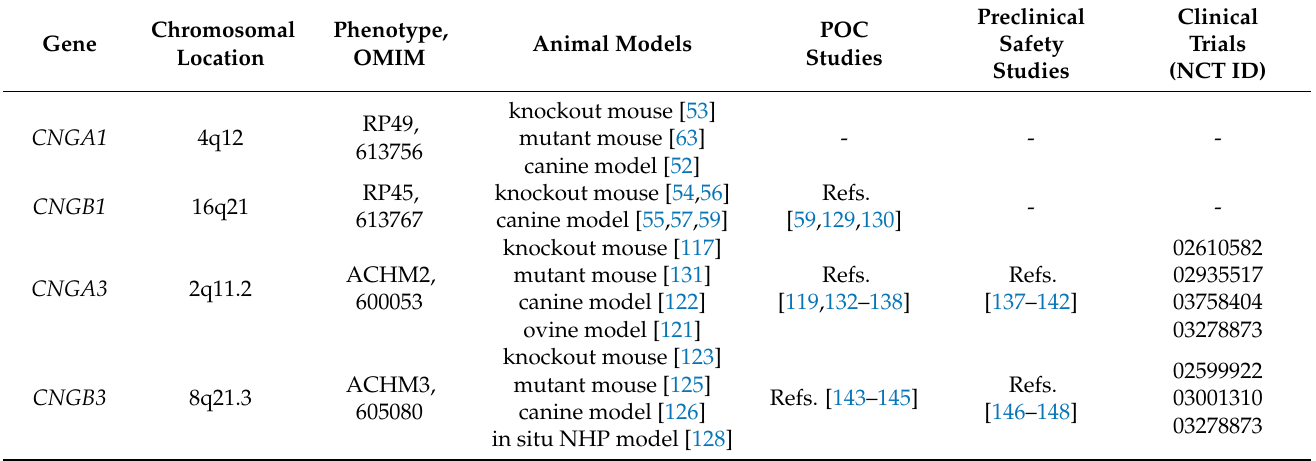
Table 1. Overview of retinal CNG genes, associated human diseases, animal models, and